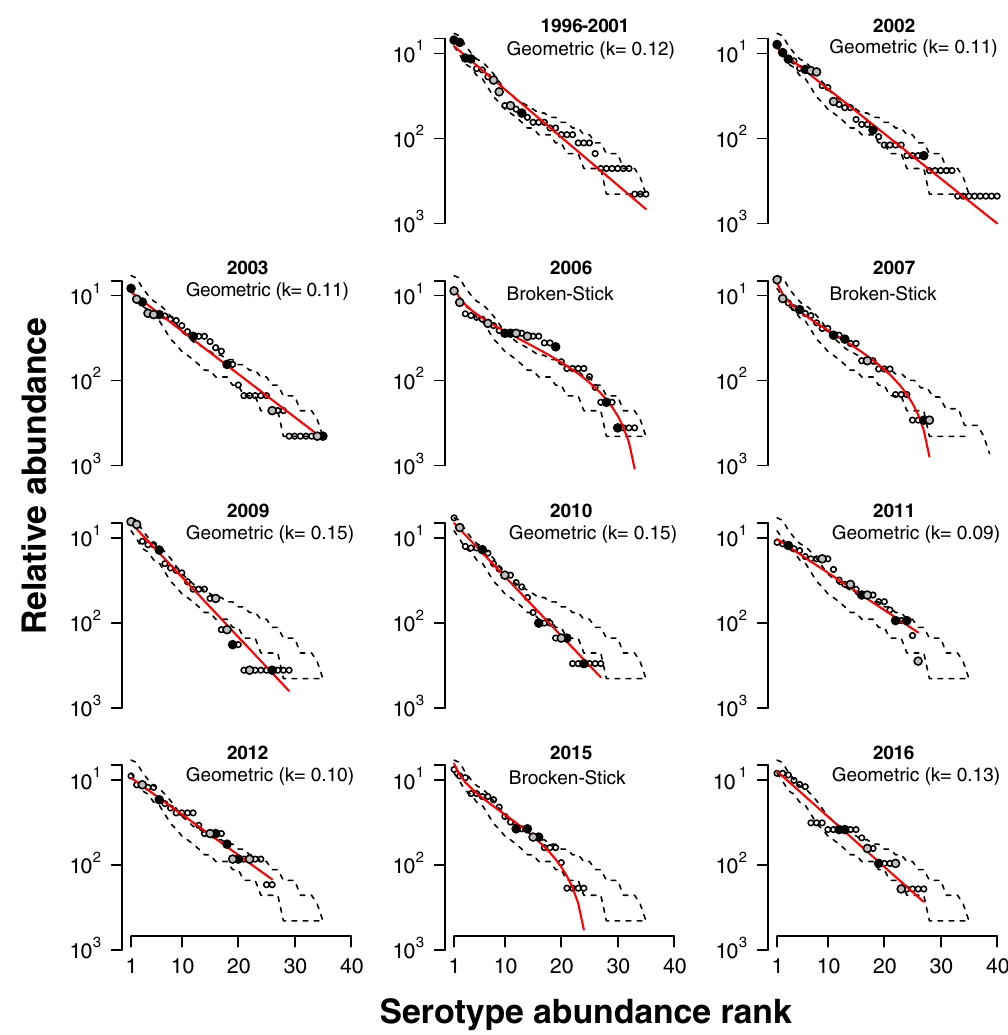
Figure 3. Pneumococcal serotype succession and community structure. Rank abundance curves depicting relative serotype abundance distribution per year. Each panel shows the serotypes (circles) ranked by the logarithm of their relative abundance. Large black circles indicate serotypes targeted by PCV7, large gray circles indicate the six serotypes targeted by PCV13 only, smaller white circles indicate serotypes not targeted by PCV13. Dashed lines in all panels correspond to 95% confidence interval of serotypes abundance during the pre-PCV period (from 1996 to 2001 as indicated in the first panel). Red lines shows the distribution that better fits the data in each year. Below each year, the name of the distribution that better fits the data is indicated. For the geometric distributions, the slope (k) is also